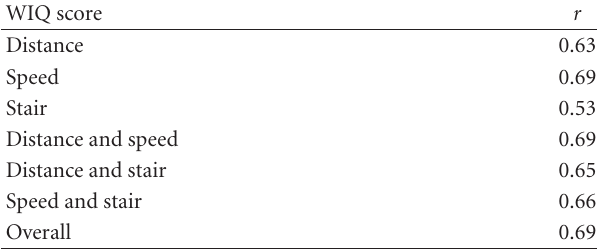
Table 3: Partial correlation coe ffi cients ( r ) of the scores of the Walking Impairment Questionnaire relative to peak walking time (ln